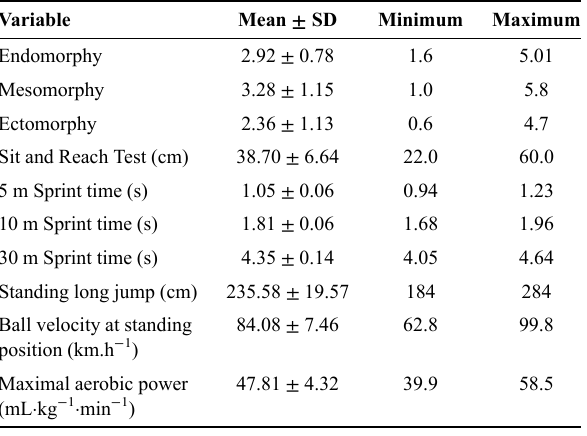
Table 2 - Somatotype values and performance measures for elite young handball players.